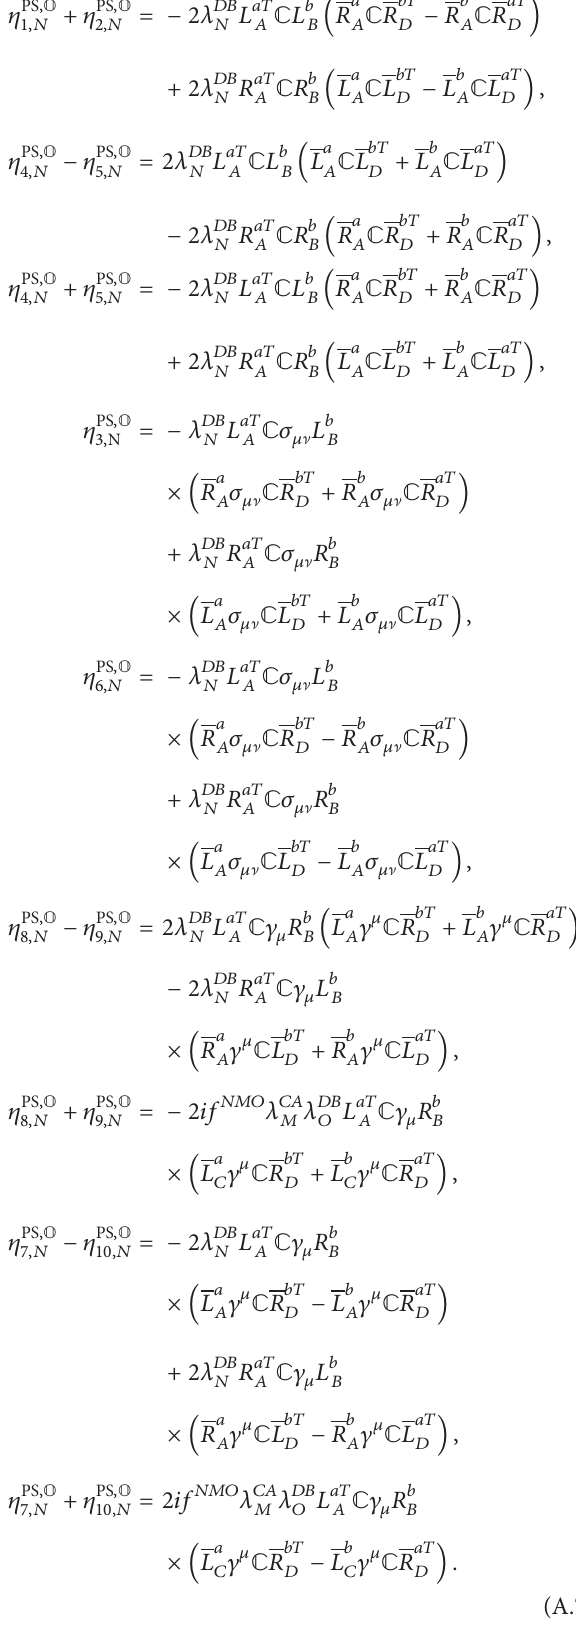
Table 4: Flavor octet tetraquark currents of 𝐽 𝑃 = 0 + classified